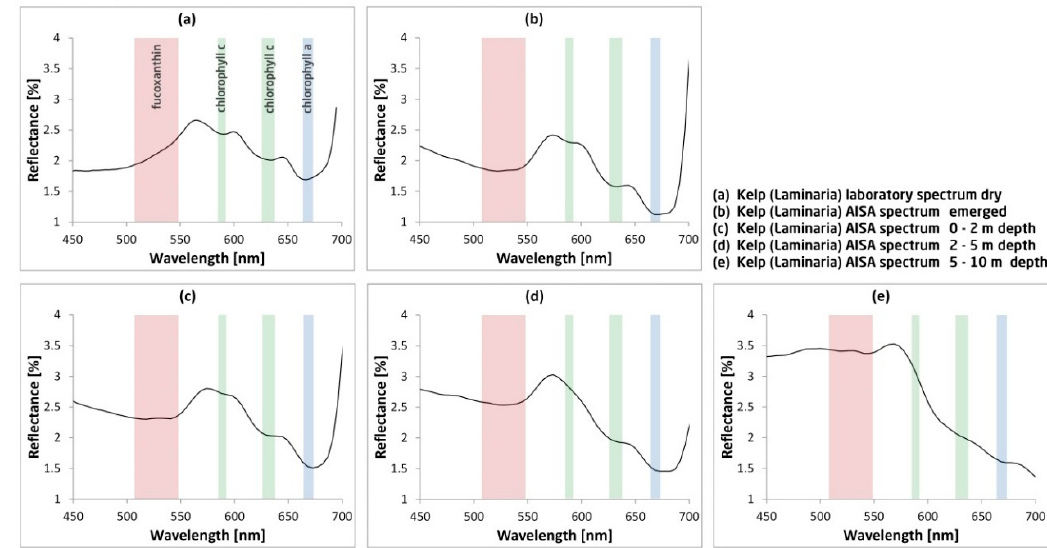
Figure 4. Savitzky-Golay smoothed kelp ( Laminaria digitata ) laboratory measurements ( a ) and Savitzky-Golay ROI AISA kelp ( Laminaria hyperborea ) spectra with varying water cover ( b – e ).